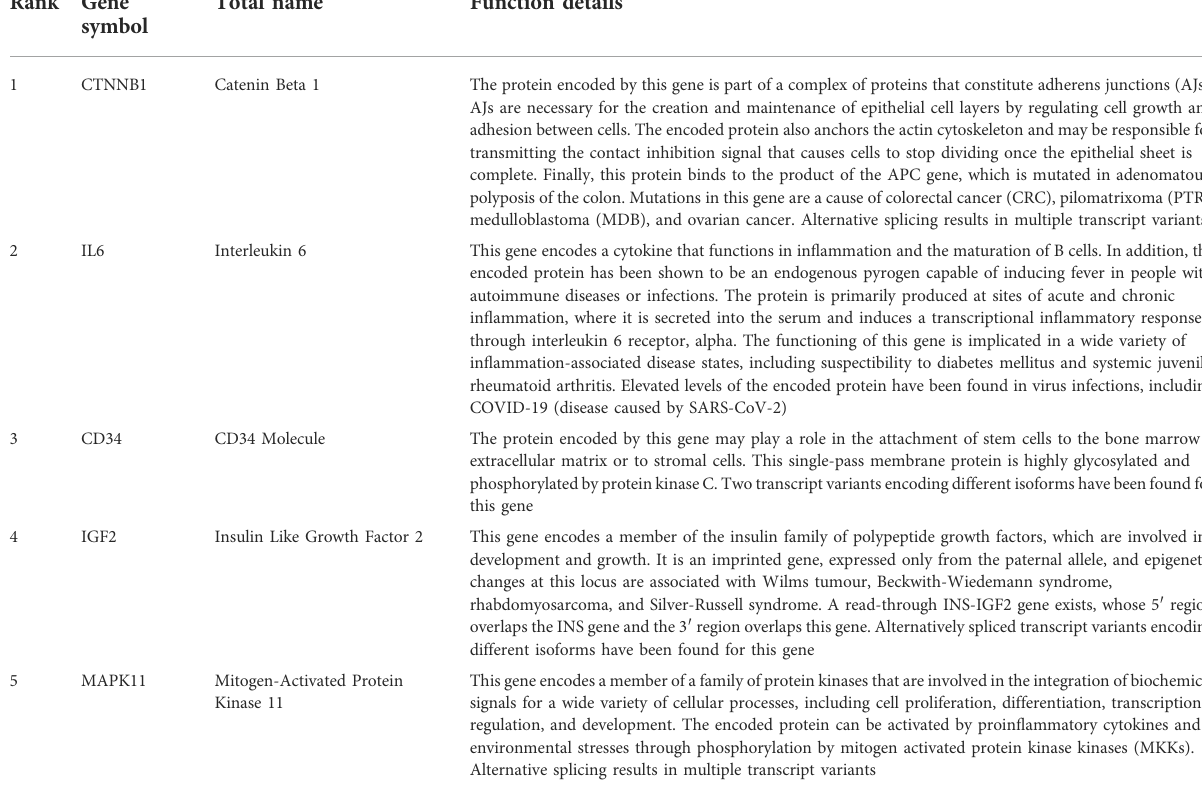
TABLE 2 The gene symbol and function details of the hub